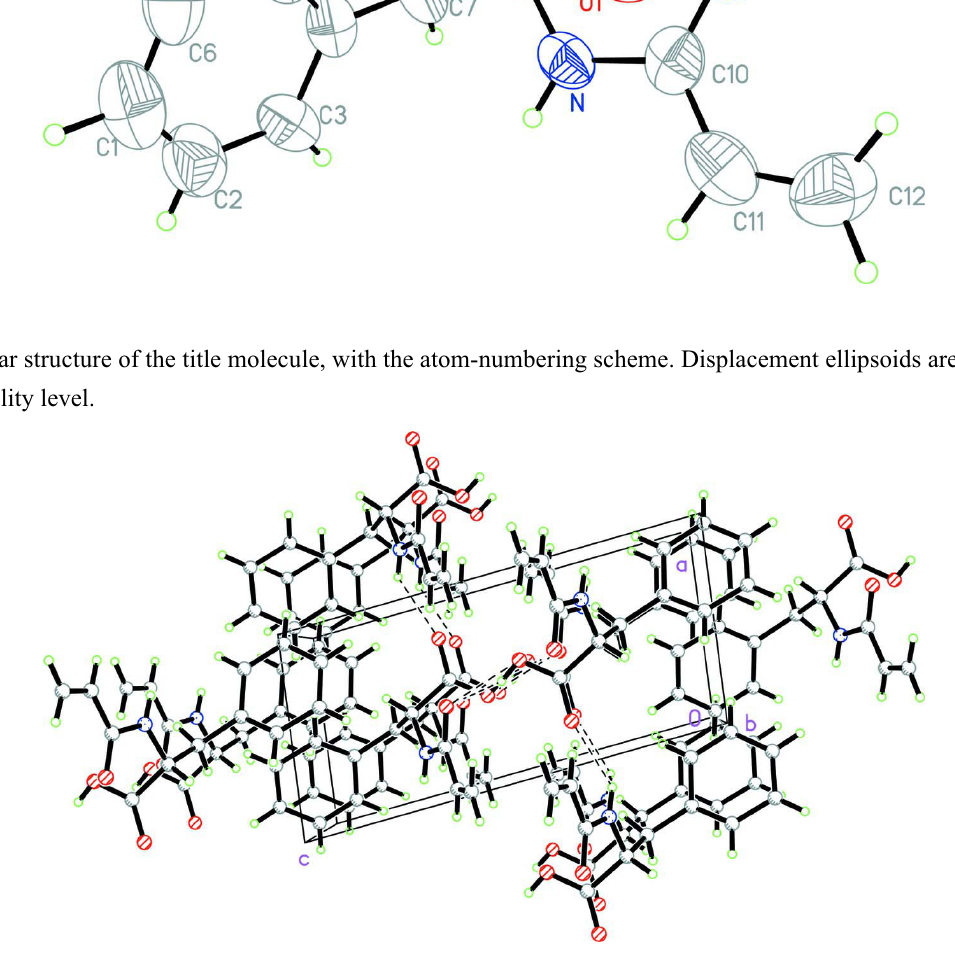
A packing diagram of the title compound. Hydrogen bonds are shown as dashed